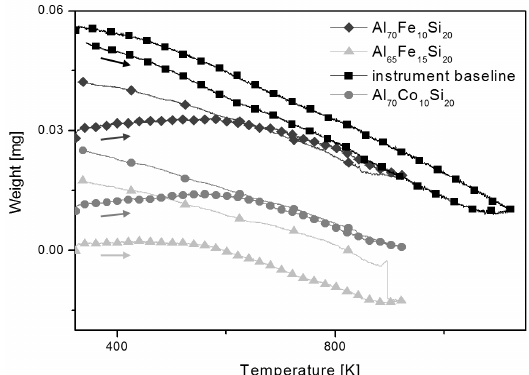
Figure 7. XRD patterns of Al during heat treatment at temperatures from 448K to 763K. Dotted lines mark fcc-Al phase peaks, dashed lines mark Si phase